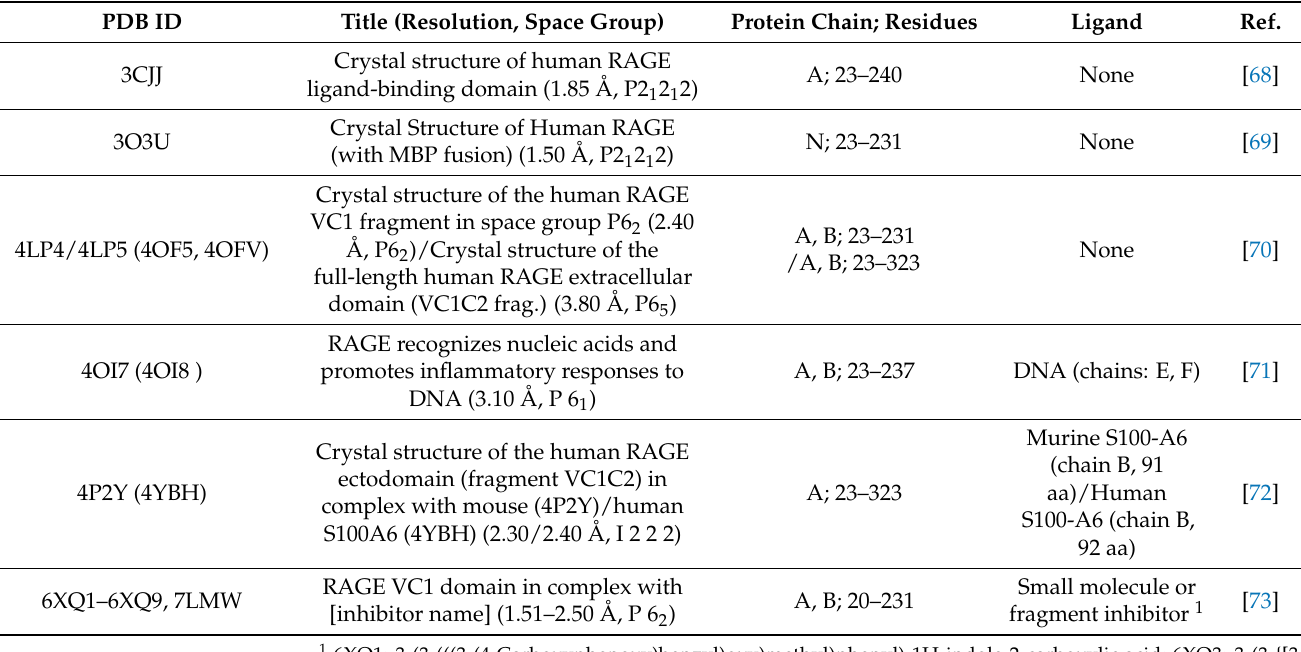
Table 4. X-ray structures of